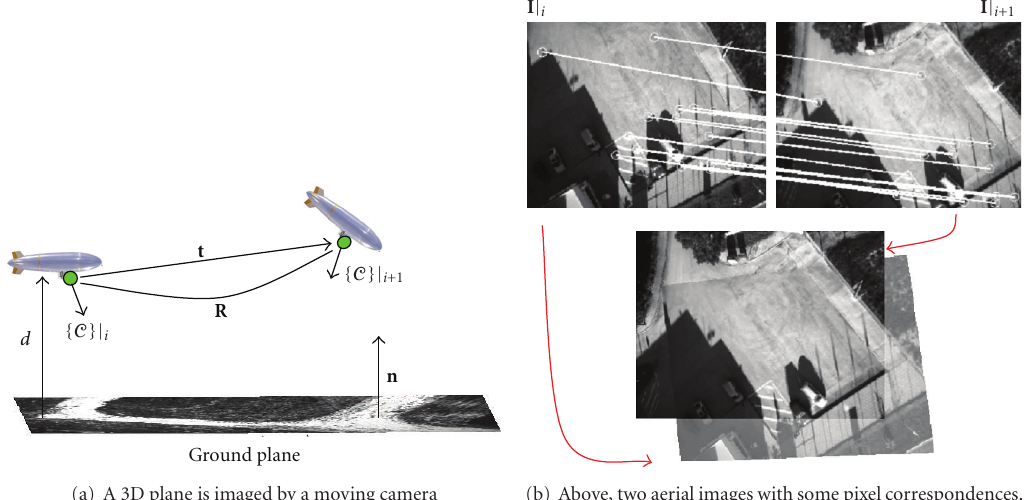
Figure 4: A 3D plane imaged by a moving camera induces a